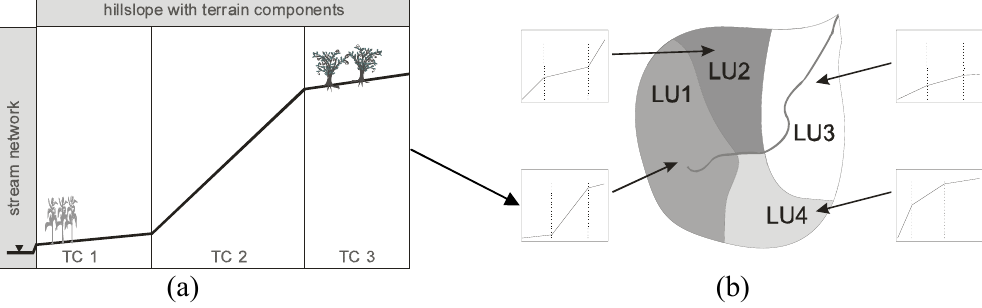
Figure 1: Spatial discretisation of the WASA-SED model (adapted after Güntner 2002): an example with 3 terrain components (TC) describing a catena and 4 landscape units (LU) describing a sub-catchment